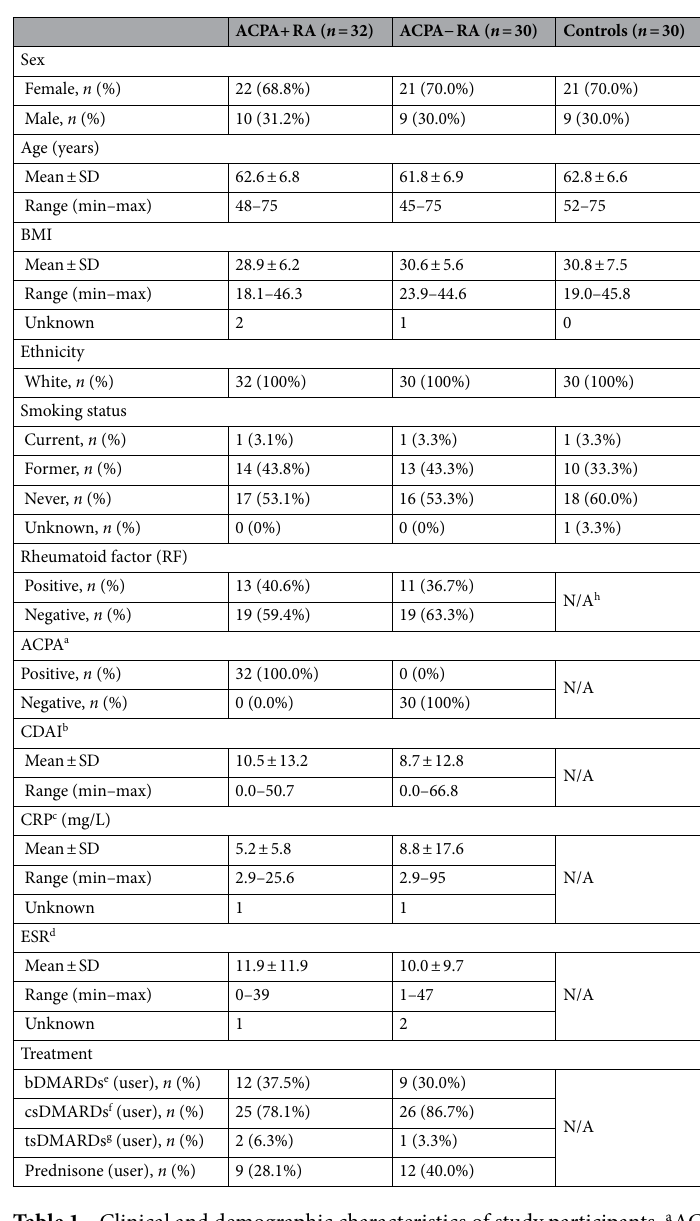
Table 1. Clinical and demographic characteristics of study participants. a ACPA, anti-citrullinated protein antibodies; b CDAI, Clinical Disease Activity Index; c CRP, C-reactive protein; d ESR, erythrocyte sedimentation rate; e bDMARDs, biologic disease-modifying anti-rheumatic drugs (Abatacept, Adalimumab, Certolizumab, Etanercept, Infliximab, Rituximab, Tocilizumab); f csDMARDs, conventional synthetic disease-modifying anti- rheumatic drugs (Azathioprine, Hydroxychloroquine, Leflunomide, Methotrexate, Sulfasalazine); g tsDMARDs targeted synthetic disease-modifying anti-rheumatic drugs (Baricitinib, Tofacitinib, Upadacitinib); h N/A, not